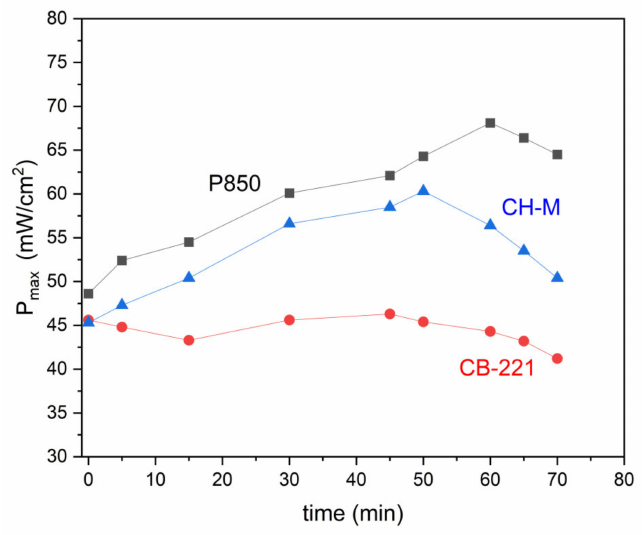
Figure 18. Dependence of P max was recorded for DC-SOFC (I) that was supplied by solid fuel P850 and following solid carbon fuels: carbon black CB-221 and charcoal CH-M. In these experiments, humidified nitrogen was introduced to anode chamber of DC-SOFC (I). Data refer to a temperature of 850 ◦